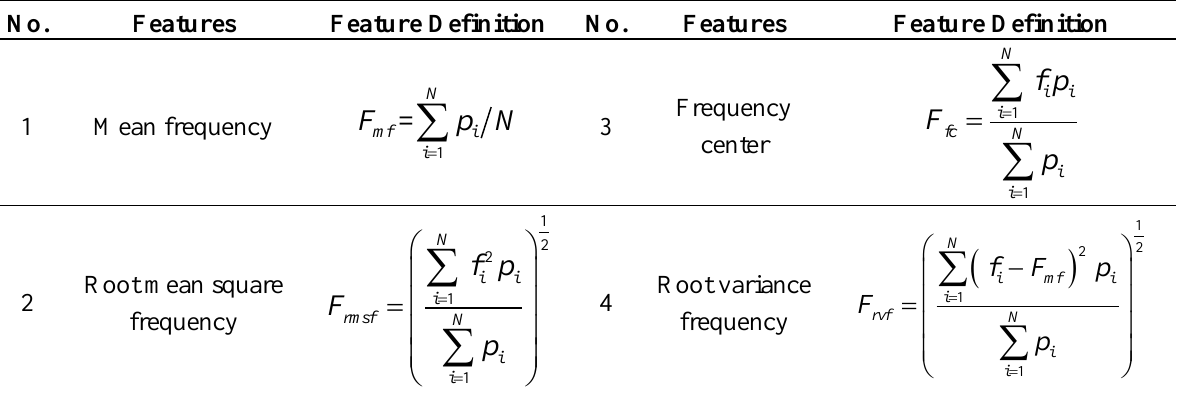
Table 2. Frequency-domain